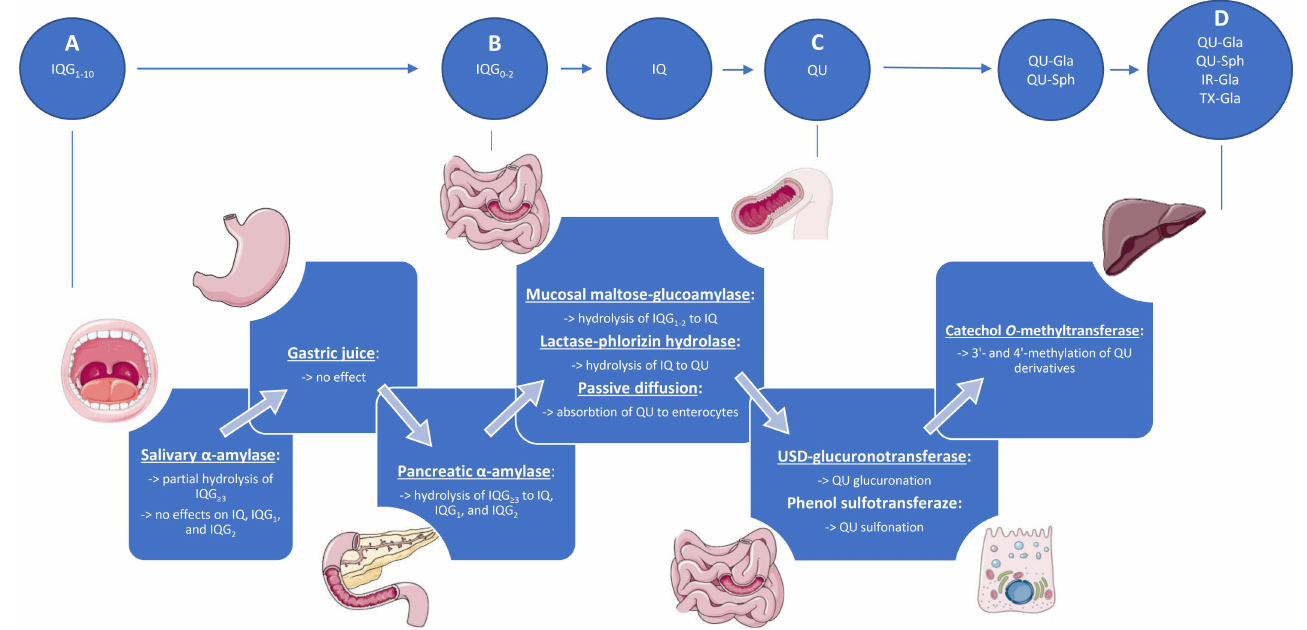
Figure 2. Metabolic pathway of EMIQ after oral ingestion. ( A ) Oral ingestion of EMIQ in the form of isoquercitrin oligoglucosides with 1 to 10 α -glucosyl moieties; ( B ) after passing the upper gastrointestinal system, the α -oligoglucosyl chain of EMIQ components is shortened to at most two moieties due to the activity of salivary and pancreatic amylases; ( C ) the enzymes of the intestinal brush border free QU from the glycosides with IQ as an intermediate product; QU is then absorbed into the enterocytes via passive diffusion; ( D ) the metabolites of EMIQ detectable in the plasma are formed in the enterocytes and in the liver by coupling QU with glucuronic acid (Gla), sulphates (Sph), or by methylation of QU to form isorhamnetin (IR) and tamarixetin (TX).